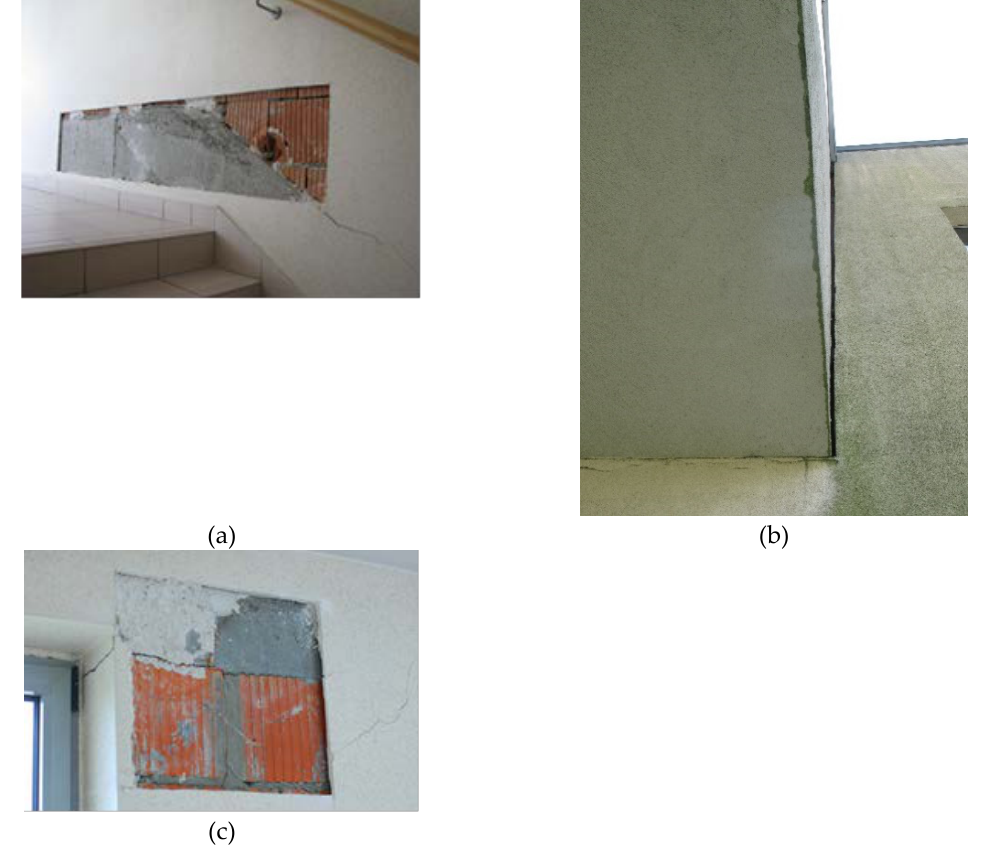
Figure 2. Typical damage: ( a ) internal cracks on the contact between frame concrete construction and filling walls ( b ) cracks in the corner of the window ( c ) cracks in dilatation zone.